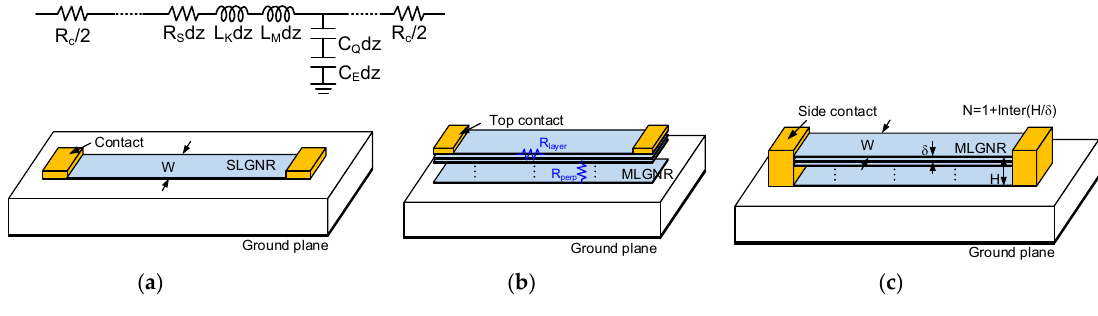
Figure 2. Schematics of ( a ) monolayer GNR interconnect, ( b ) top-contacted MLGNR, and ( c ) side-contacted MLGNR interconnect.